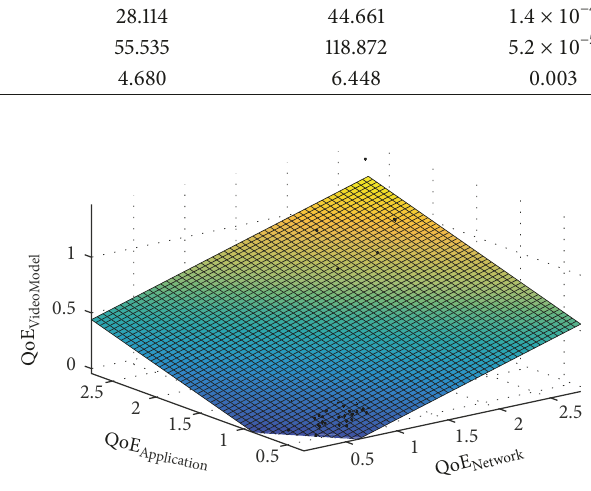
Figure 18: Final integrated video